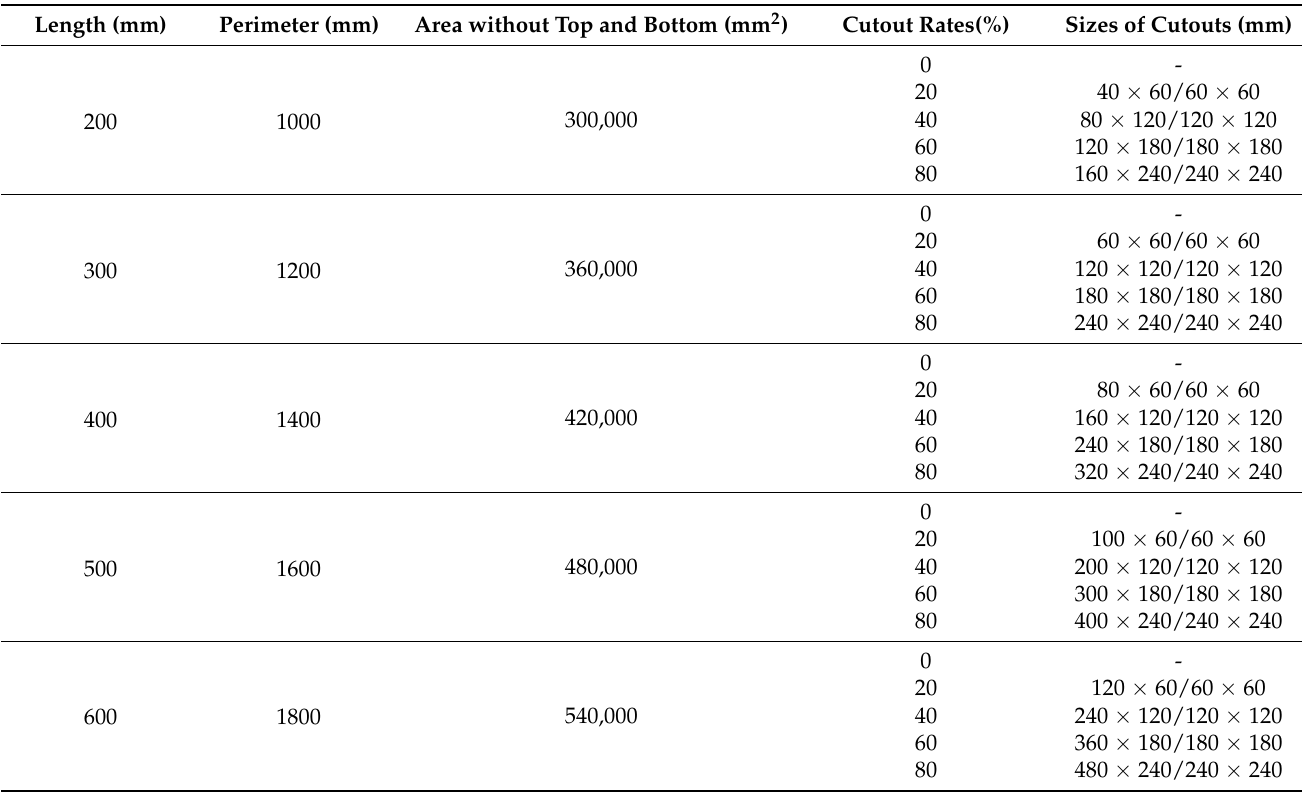
Table 2. Configurations for dimensions of samples for this study (width and height of 300